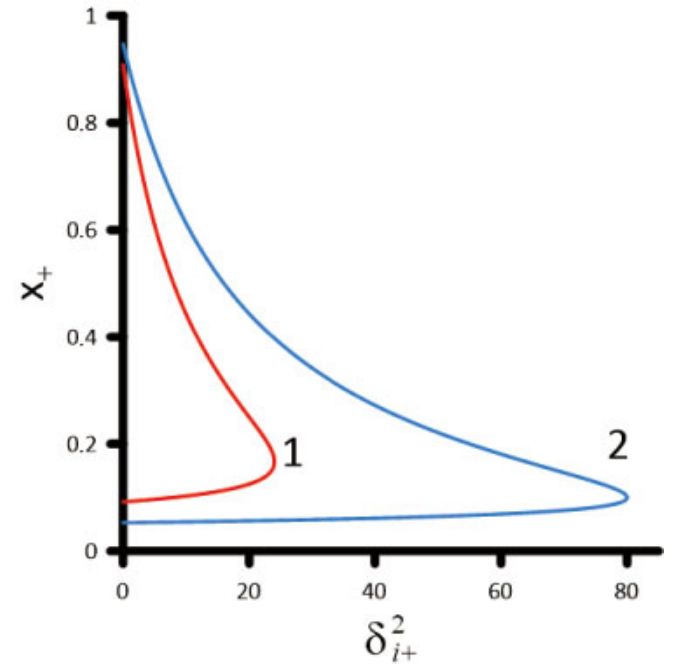
Figure 3. Dependence of the positron energy (in units of the initial gamma-quantum energy) on its outgoing angle at different energies of the initial gamma-quantum. Curve 1 corresponds to energy ω i = 300 MeV ( ε i = 3, ω thr = 100 MeV ) , curve 2 is ω i = 500 MeV ( ε i = 5, ω thr = 100 MeV )